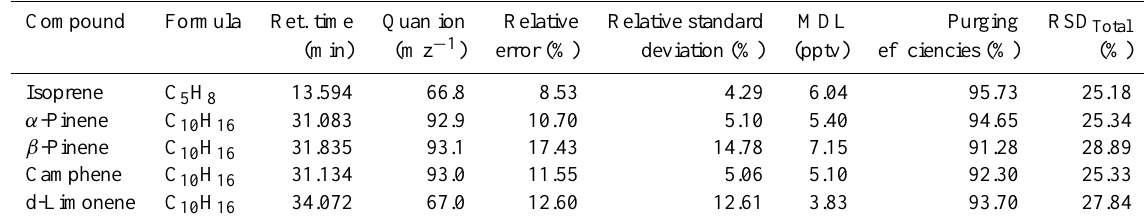
Table 1. Compound attributes and error analysis.